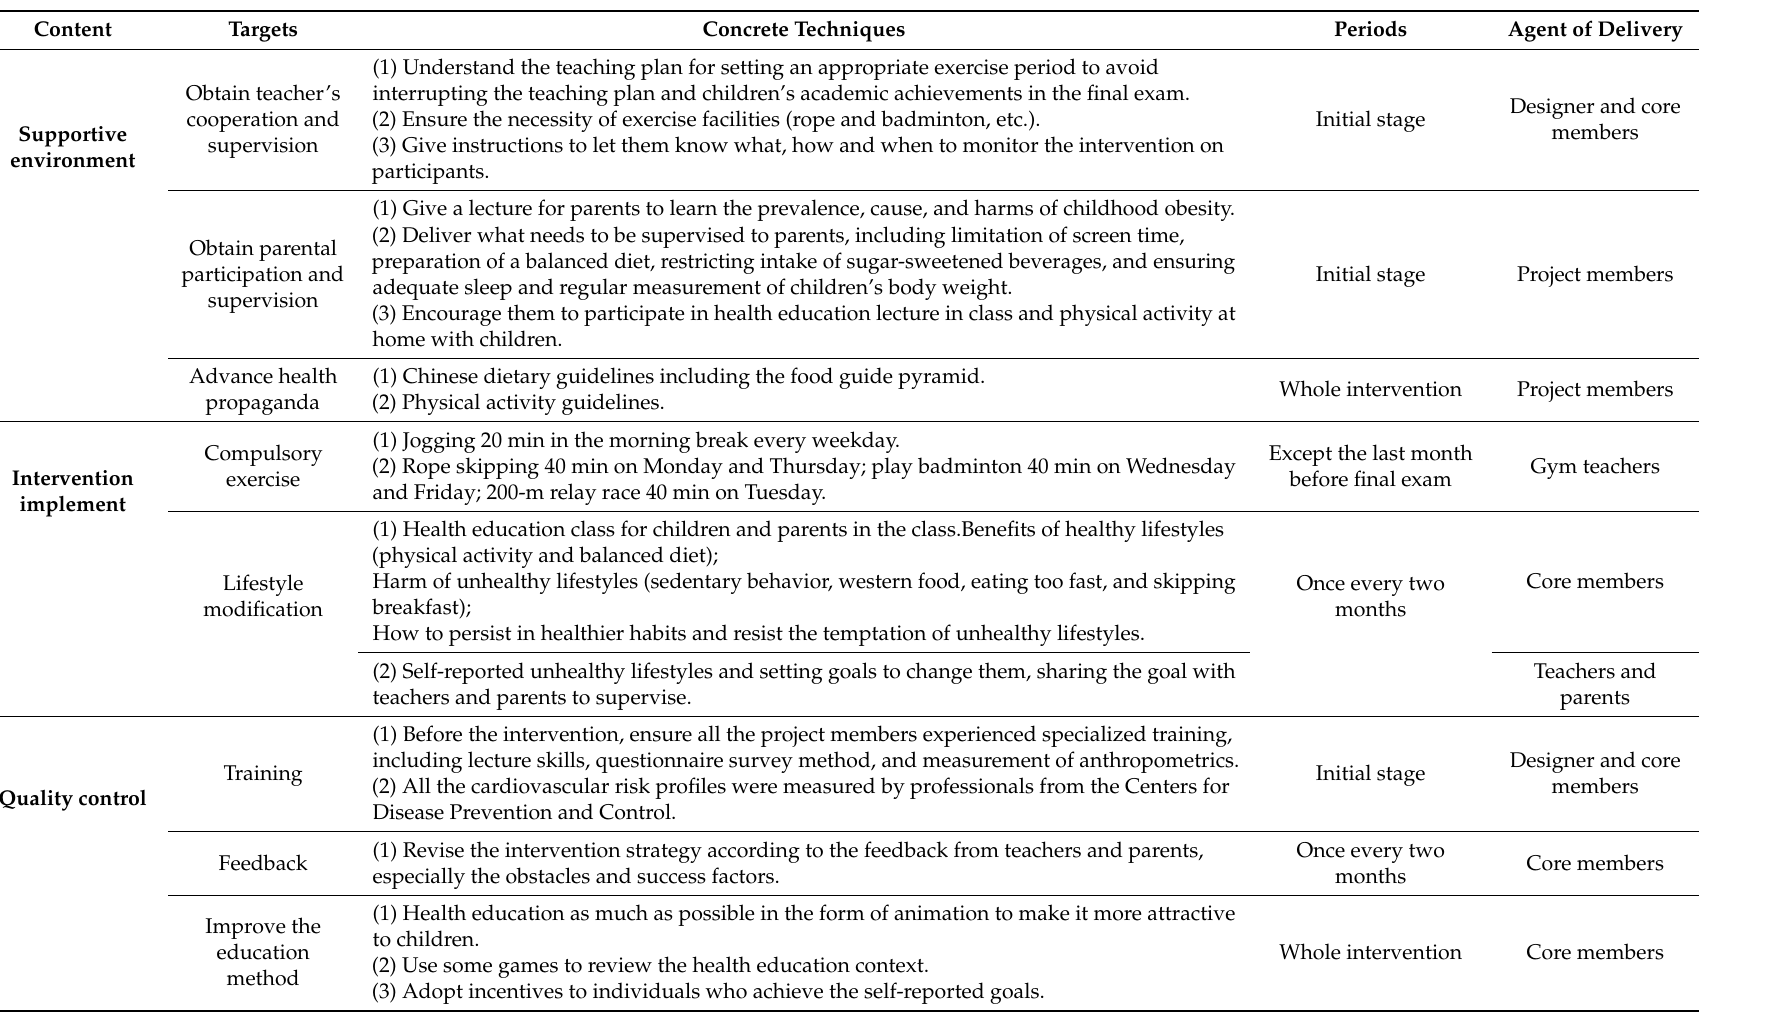
Table 1. Details of intervention